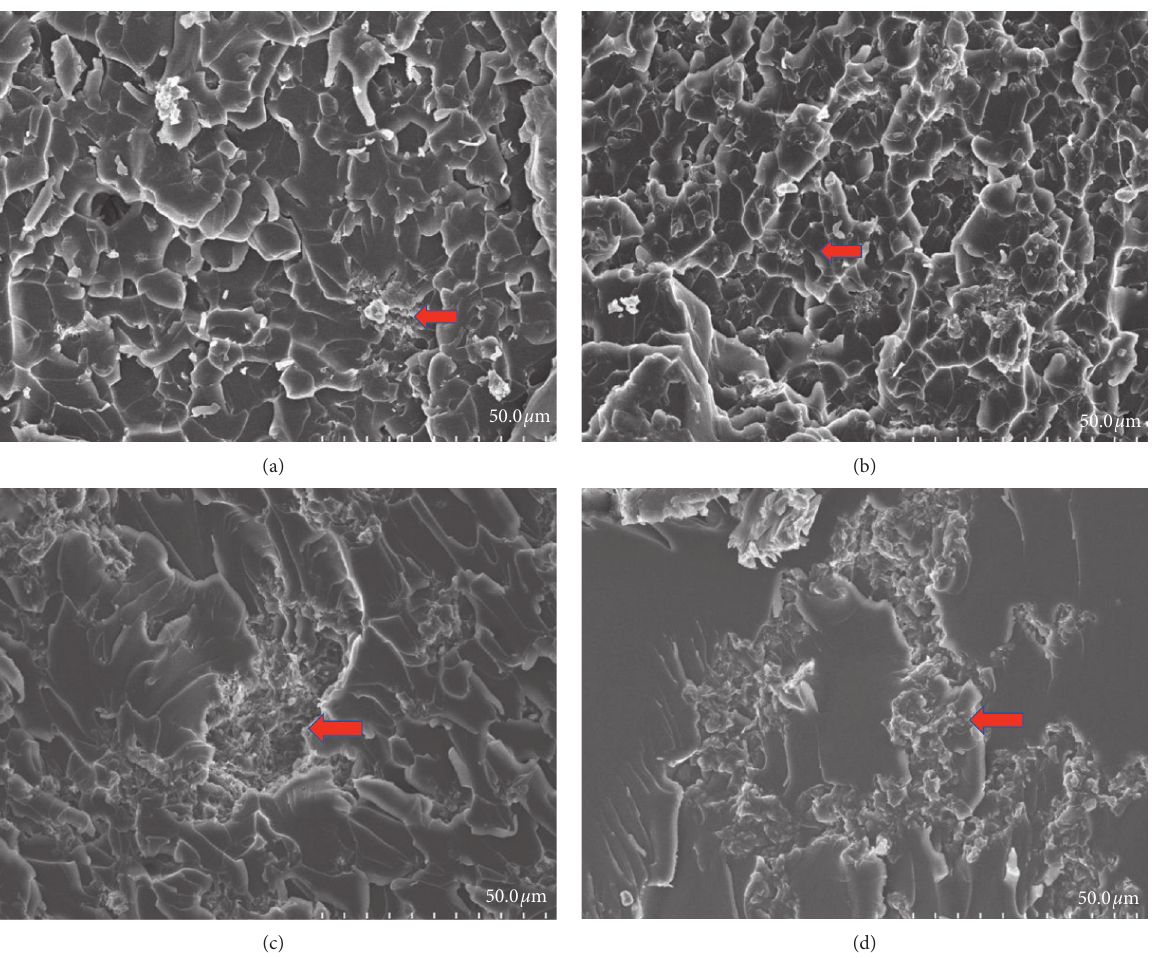
Figure 3: FE-SEM image of epoxy Epikote 240/nanoclay I.30E nanocomposite materials: (a) 1% wt nanoclay, (b) 2% wt nanoclay, (c) 3% wt nanoclay, and (d) 4% wt Table 2: Results for flammability tests (reaction to small flame) oxygen index (OI) and UL 94 for nanocomposites. Epoxy Epikote 240/nanoclay I.30E nanocomposites